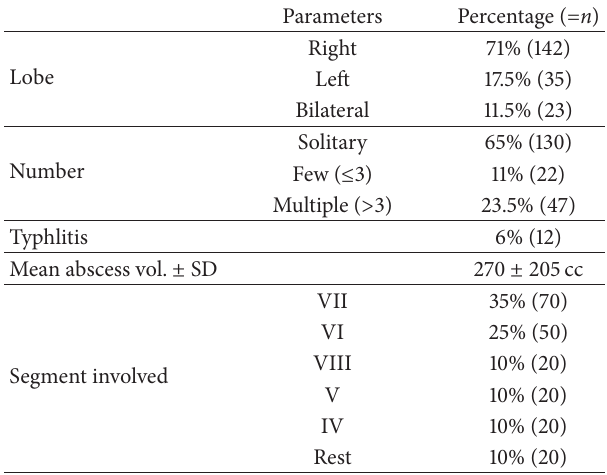
Table 3: Ultrasonography abdomen findings for liver abscess: right lobe solitary abscess was the most common pattern. Segments 7 and 6 were the most common sites of abscess. Associated typhlitis, an uncommon finding with ALA, was present in only 6% patients.